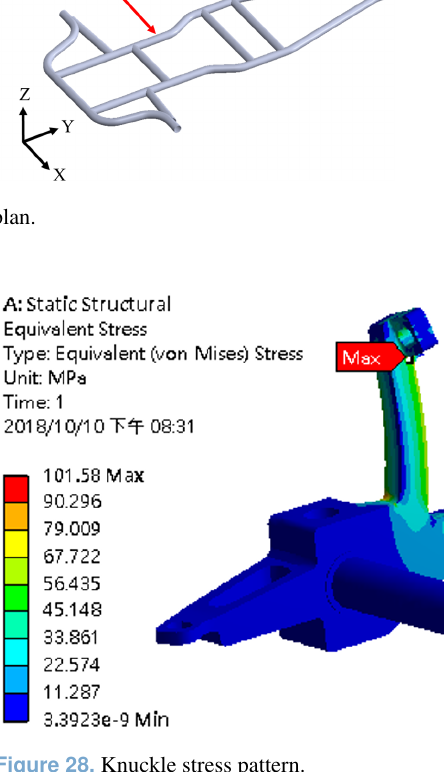
Figure 28. Knuckle stress